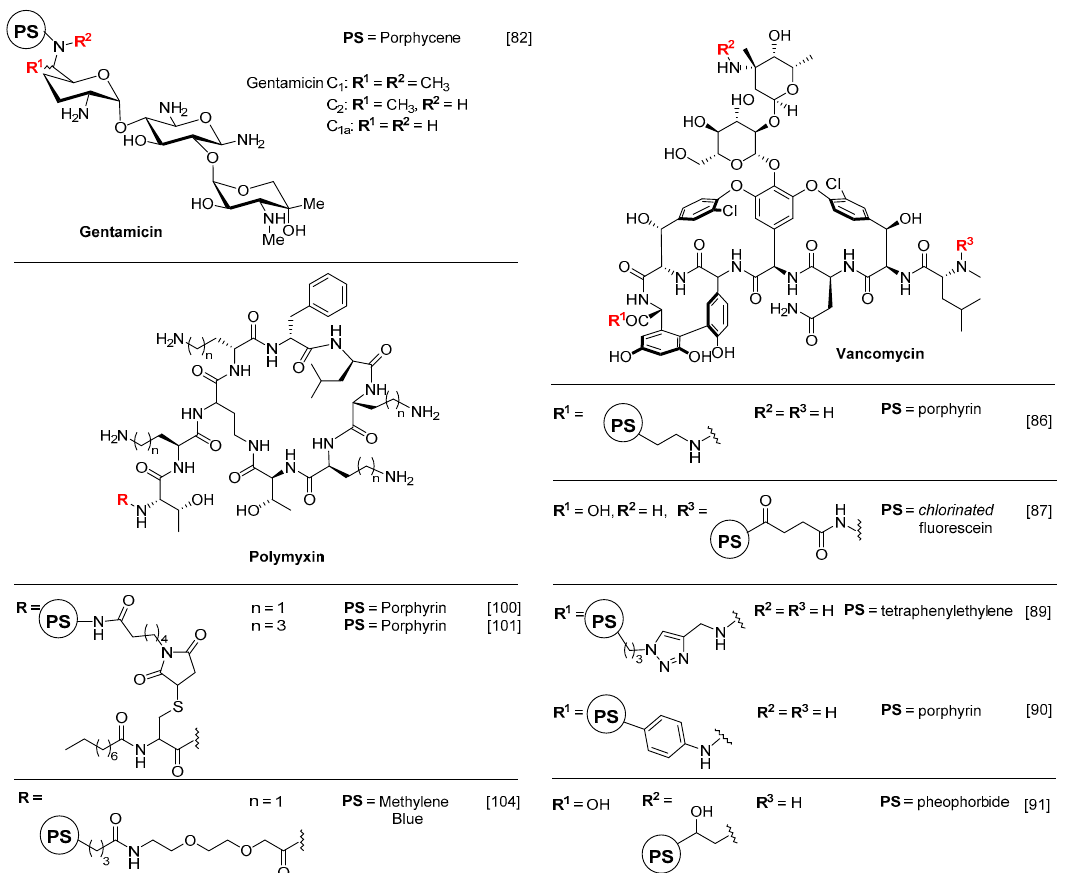
Figure 5. Recent examples of PS-conjugates using antibiotics and antimicrobial peptides (AMPs) as targeting or membrane-disrupting sub-units.